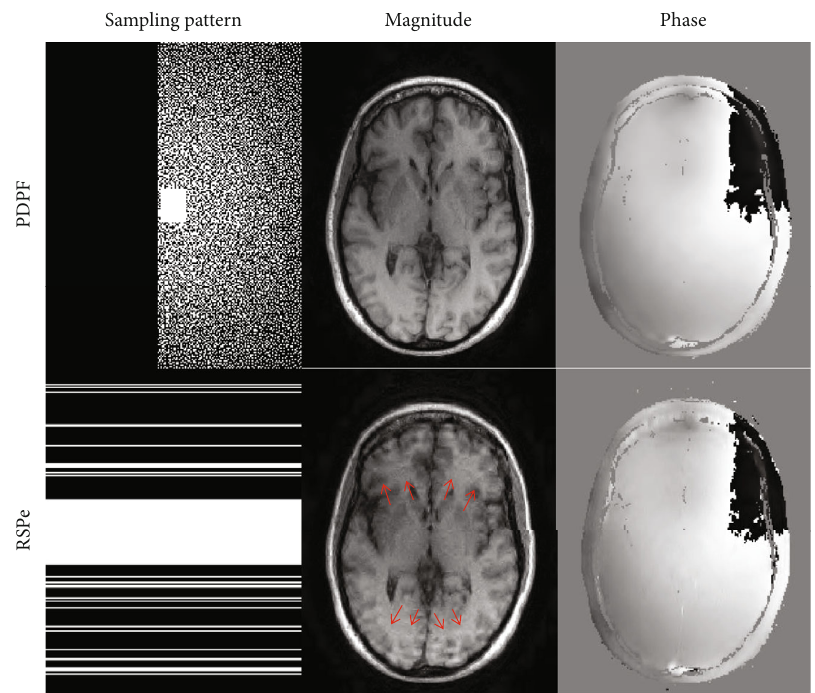
Figure 1: The results of the phase cycling method under two undersampling schemes at 30% sampling rate on a brain dataset.